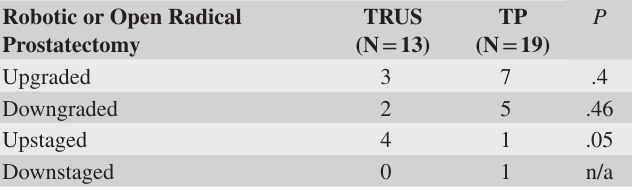
Table 5. Rates of Upgrading, Downgrading, Upstaging, and Downstaging in TRUS Versus TP Prostate